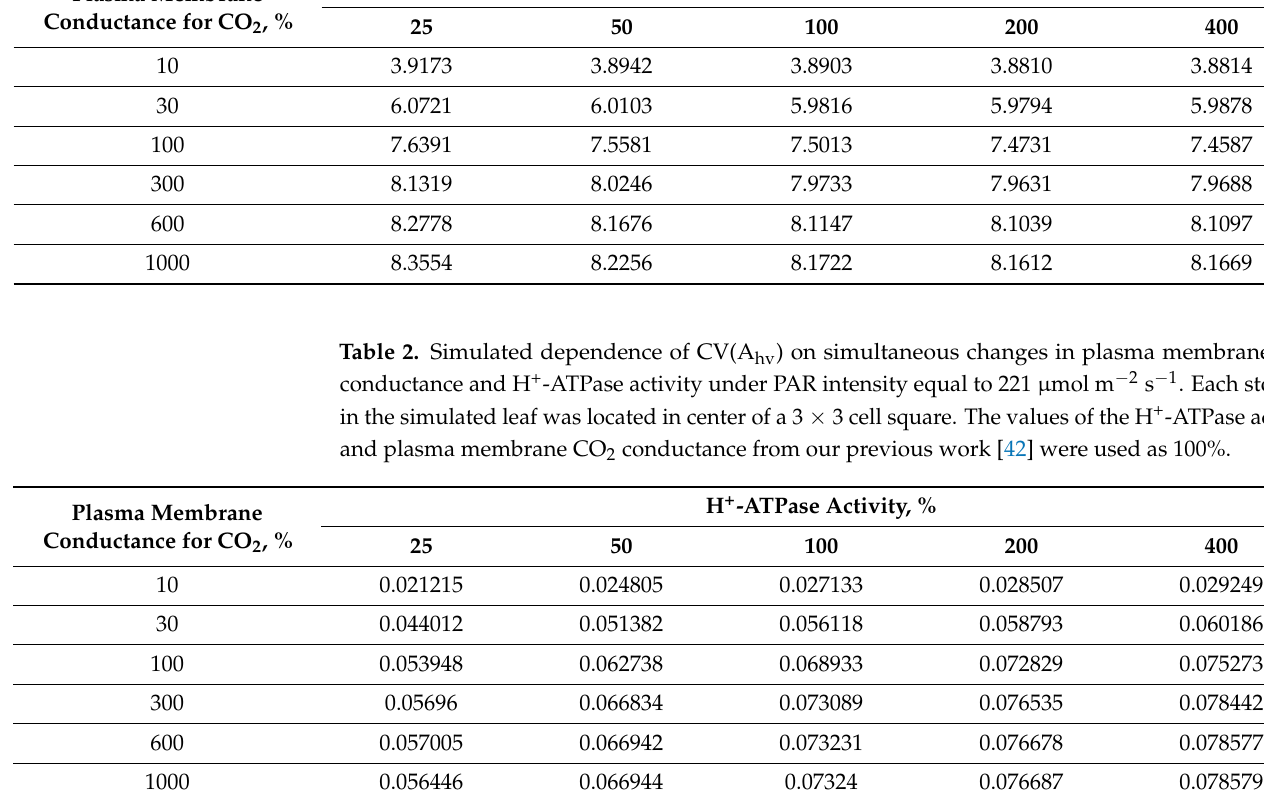
Table 1. Simulated dependence of A hv on the plasma membrane CO 2 conductance and H + -ATPase activity under PAR intensity equal to 221 µ mol m − 2 s − 1 . Each stomata in the simulated leaf was located in center of a 3 × 3 cell square. The values of the H + -ATPase activity and plasma membrane CO 2 conductance from our previous work [42] were used as 100%.